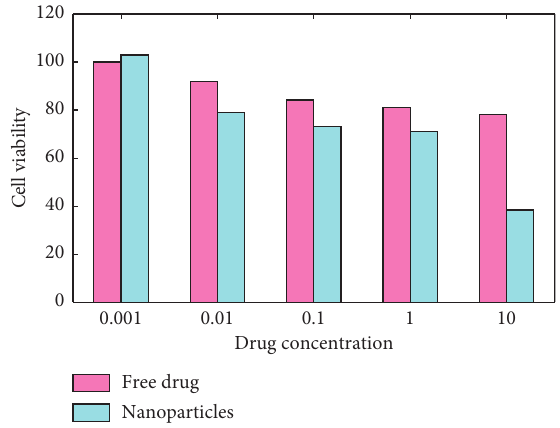
Figure 4: The killing of lung tumor cells by drugs. Table 2: Five-level classification of abduction movements.